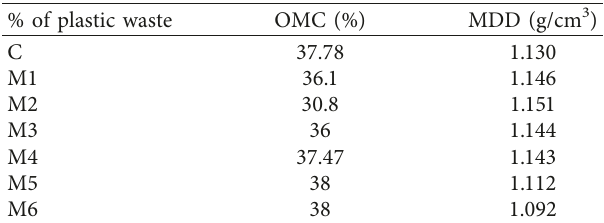
Table 3: OMC and MDD